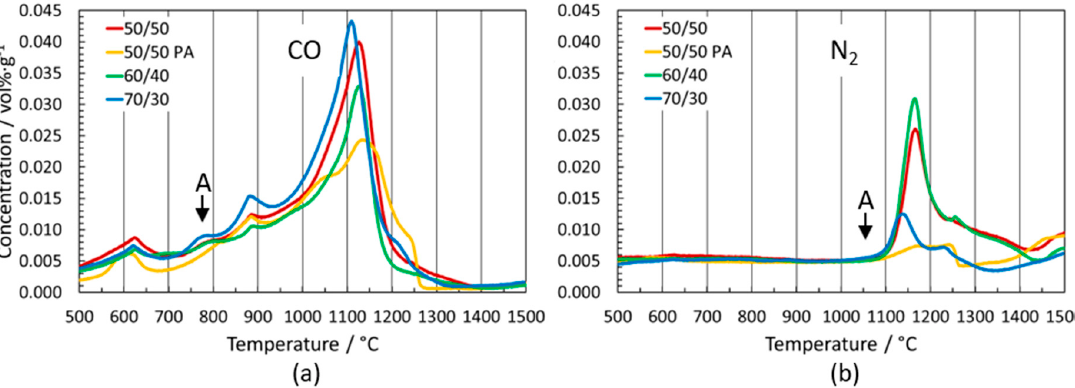
Figure 4. CO ( a ) and N 2 ( b ) outgassing of cermet formulations Ti(C,N)-Mo 2 C-(Ta,Nb)C-Co/Ni with different C/N ratio of the admixed Ti(C,N), nominally Ti(C 0.5 N 0.5 )—“50/50”, Ti(C 0.6 N 0.4 )-A—“60/40” and Ti(C 0.7 N 0.3 ) “70/30” and one grade with admixed “pre-alloyed” (Ti,W)C (“50/50 PA”), corresponding in overall composition to that of the Ti(C 0.5 N 0.5 )-containing formulation.